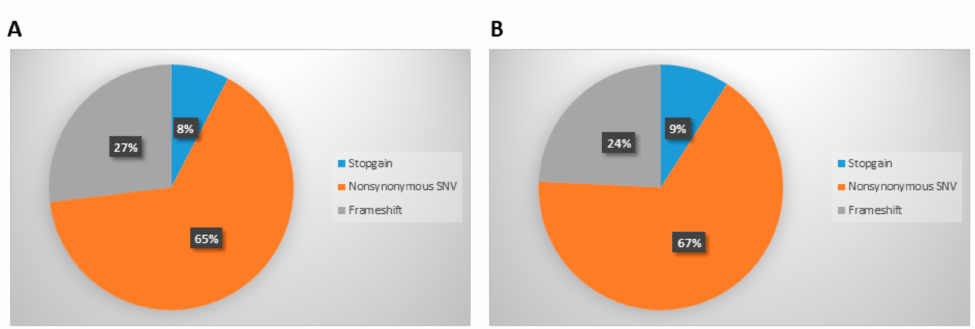
Figure 3. Graphical representation of the types of mutations detected in cells ( A ) and on dsDNA derived from exosome isolation ( B